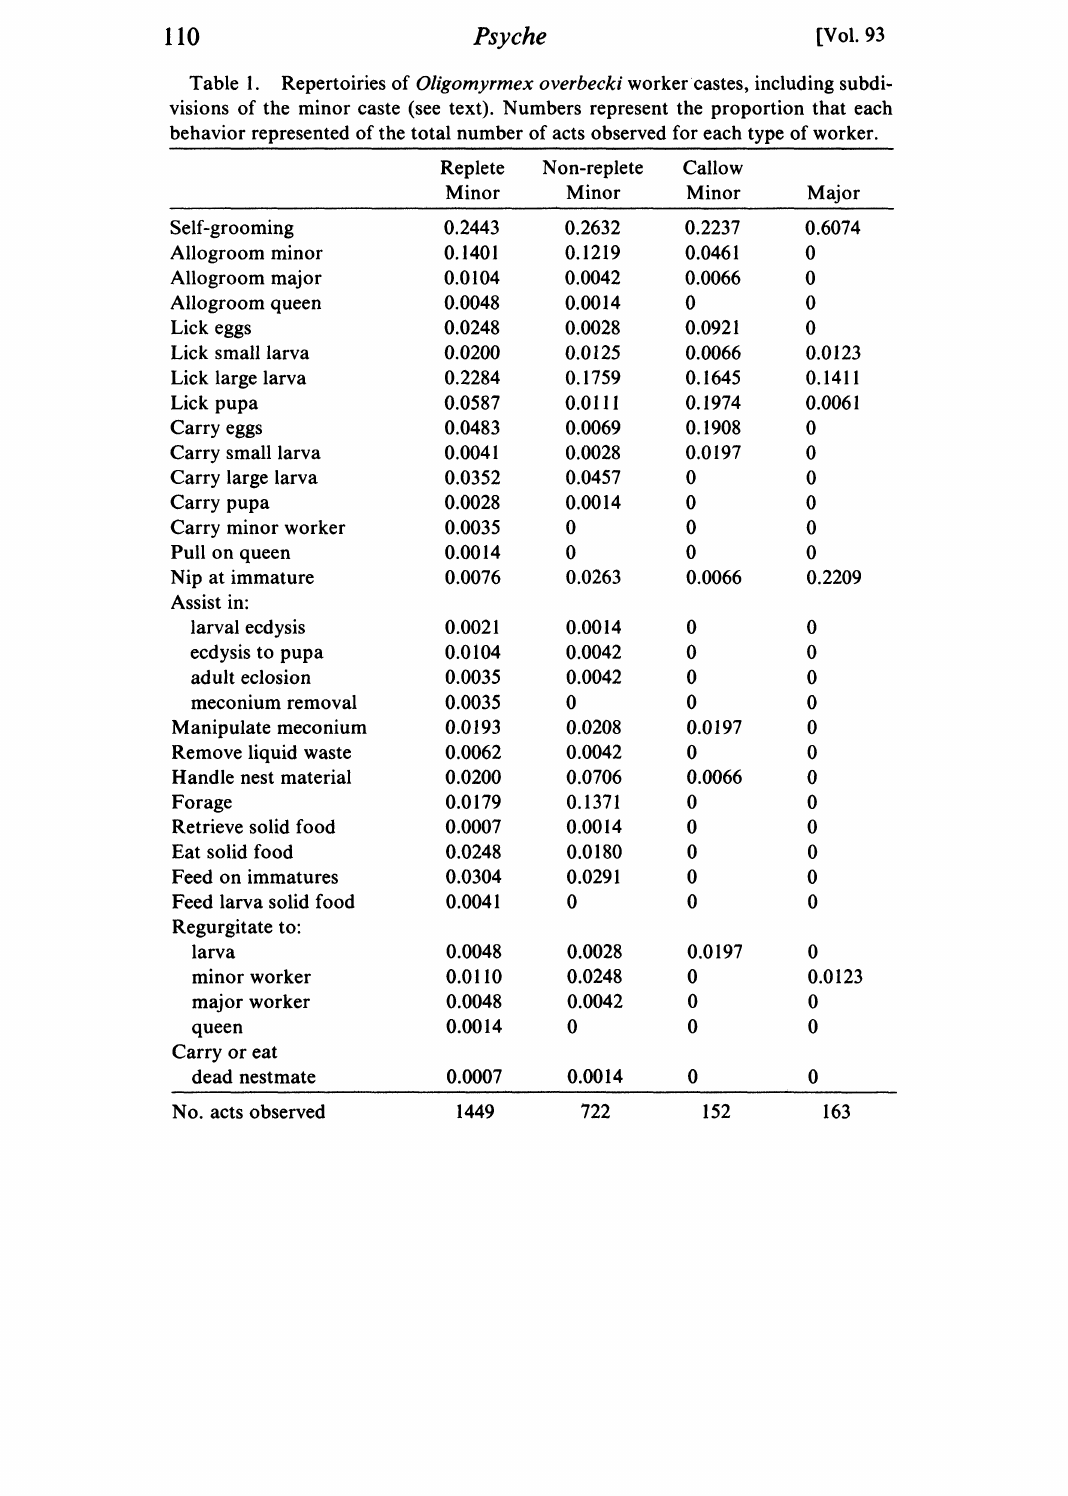
Table 1. Repertoiries of Oligomyrmex overbecki workercastes, including subdi- visions of the minor caste (see text). Numbers represent the proportion that each behavior represented of the total number of acts observed for each type of